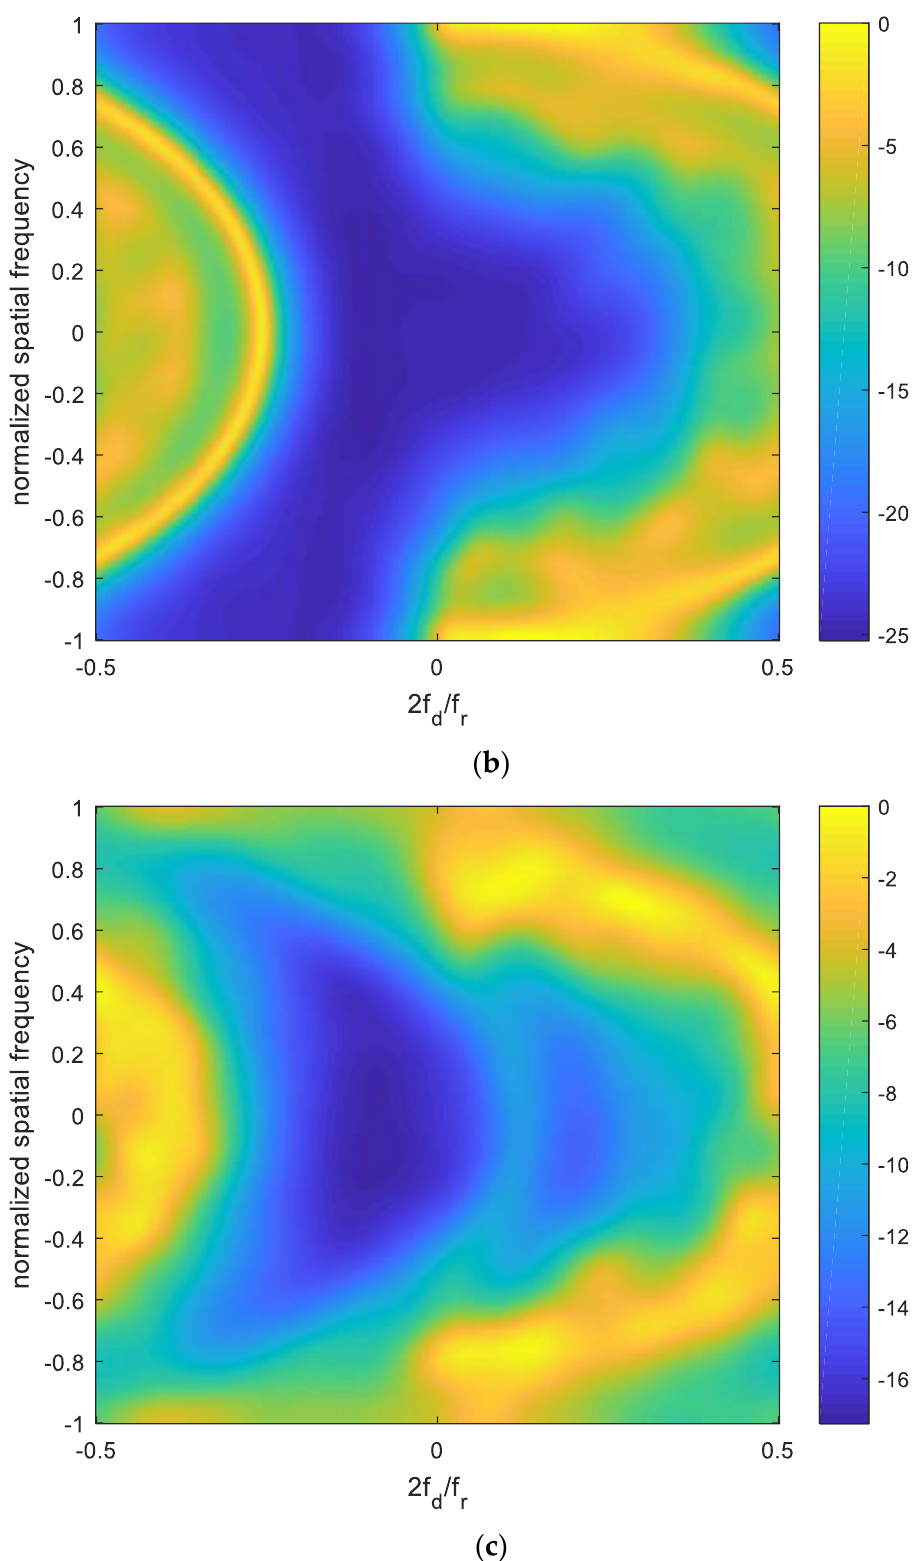
Figure 12. Ambiguous clutter power spectrum. ( a ) MIMO; ( b ) FDA; ( c ) MLC FDA.